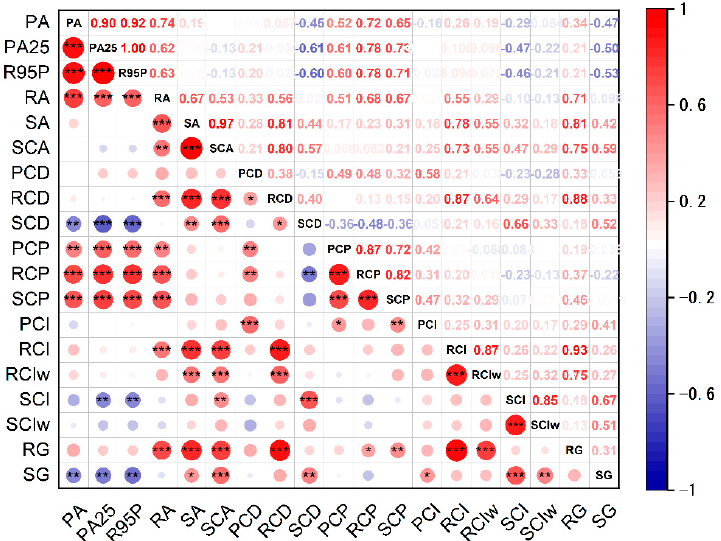
Figure 11. The Pearson correlation coefficients between the precipitation, runoff, and sediment characteristics. PA is the annual total amount of precipitation, PA25 is the annual amount of precipitation when daily precipitation ≥ 25 mm, R95P is the total precipitation amount when the daily precipitation >95th percentile of precipitation on wet days in the 1981–2010 period, RA is the annual total amount of runoff, SA is the annual total amount of sediment, SCA is the annual suspended sediment concentration, PCD is the precipitation concentration degree, RCD is the concentration degree for runoff, SCD is the concentration degree for sediment, PCP is the precipitation concentration period, RCP is the concentration period for runoff, SCP is the concentration period for sediment, PCI is the precipitation concentration index, RCI is the concentration index for runoff, RCIw is the concentration index for runoff for the wet season, SCI is the concentration index for sediment, SCIw is the concentration index for sediment for the wet season, RG is the Gini concentration index for runoff, and SG is the Gini concentration index for sediment. * Significance at 10% level; ** significance at 5% level; *** significance at 1%